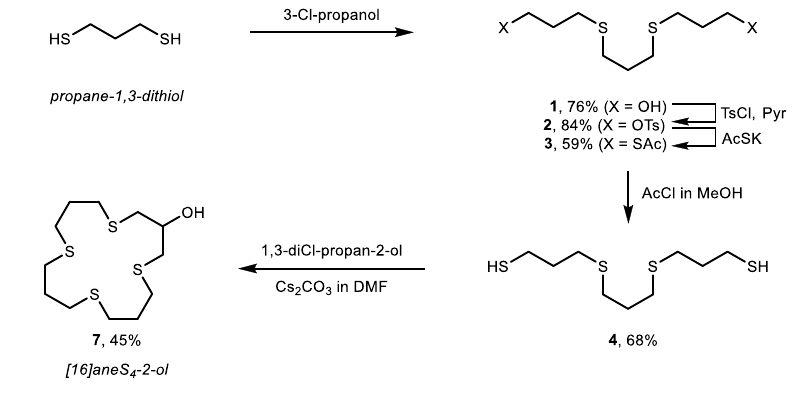
Figure 2. Synthesis of [16]aneS 4 -ol (see SI for further details).